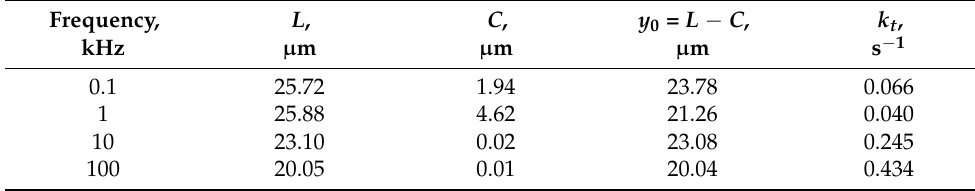
Table 1. Fitting values for the BNNS under nanosecond Table 1. Fi tt ing values for the BNNS under nanosecond pulses.